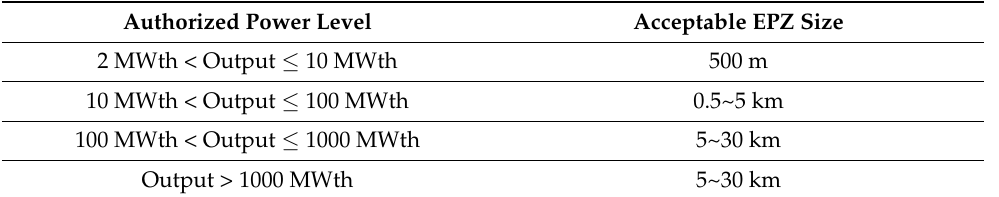
Table 3. Suggested EPZ size for NPPs.